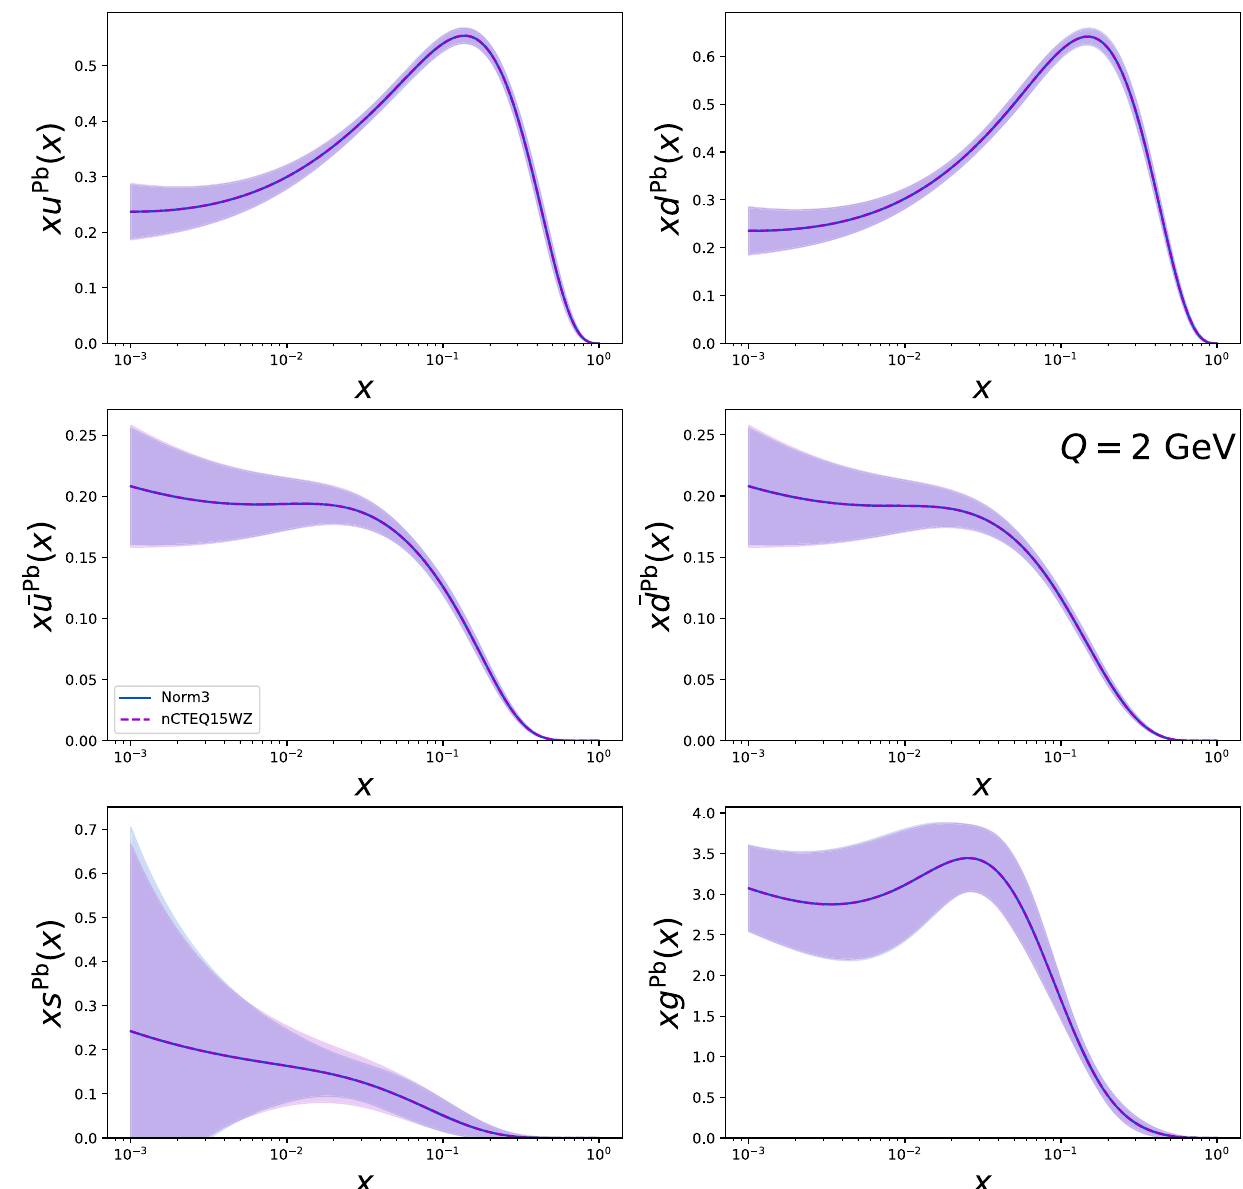
Fig. 11 Comparison of the full lead (Pb) PDFs at Q = 2GeV for nCTEQ15WZ and Norm3 fits. The uncertainty band for nCTEQ15WZ is shown in purple, Norm3 in blue. This shows that the central value of